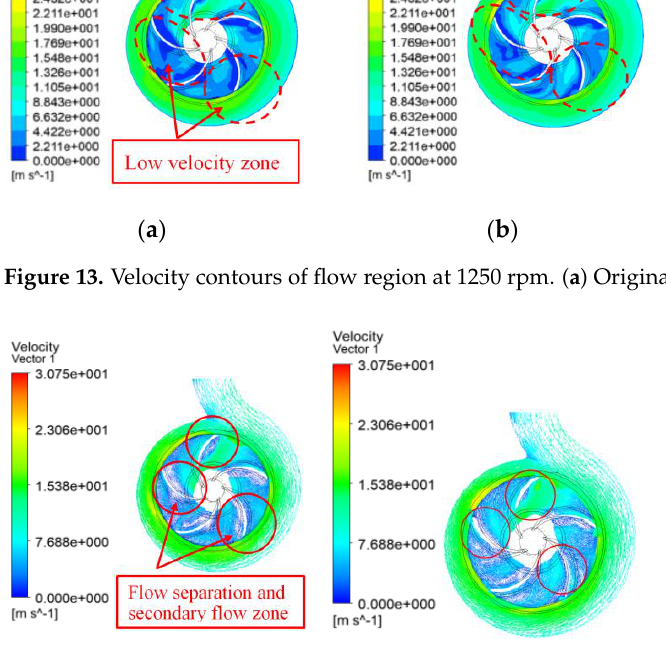
Figure 14. Velocity vector of flow region at 1250 rpm. ( a ) Original model; ( b ) rounded model.